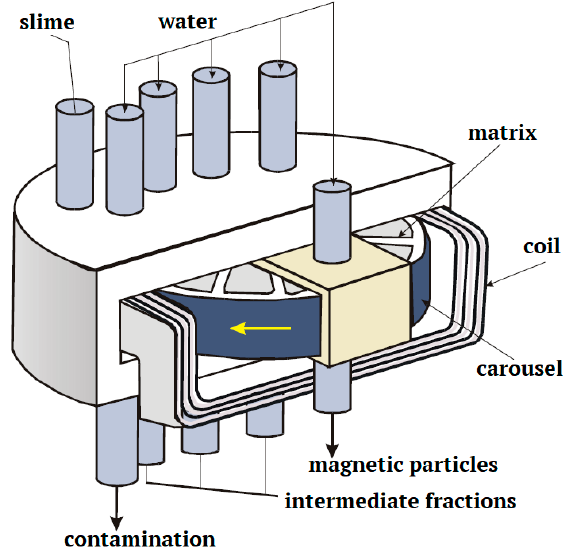
Figure 11. Schematic diagram of a superconducting magnetic separator: carousel type. Reproduced from [1] with the permission from the author H. D. Stryczewska.